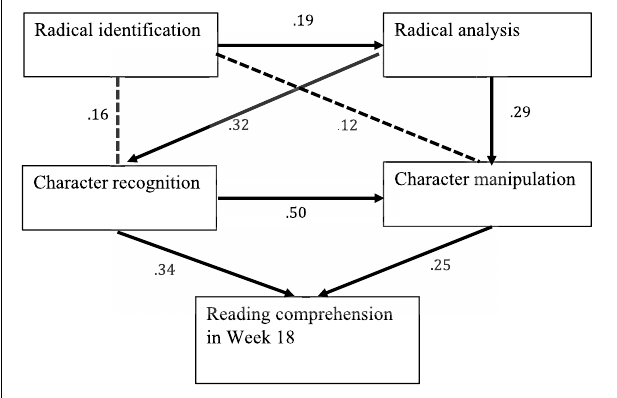
FIGURE 2 | The observed path model regarding how early radical-level and character-level grapho-morphological knowledge predicts later reading